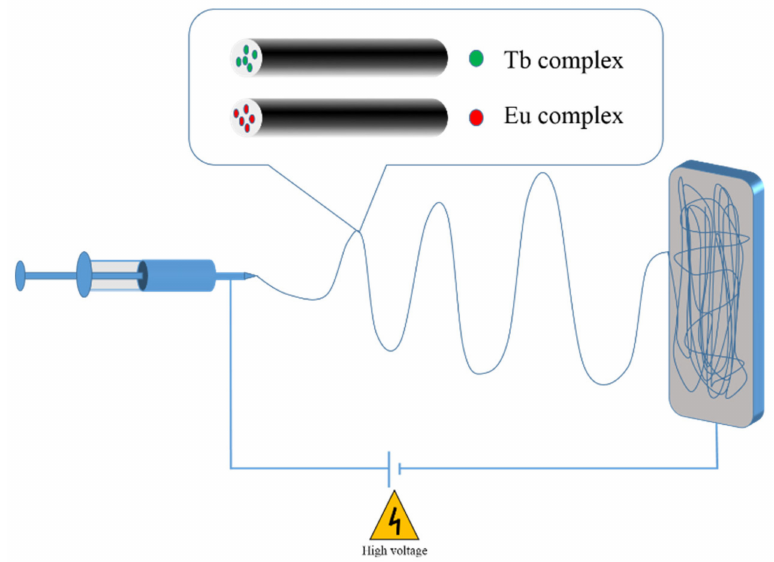
Figure 1. Schematic illustration of the electrospinning